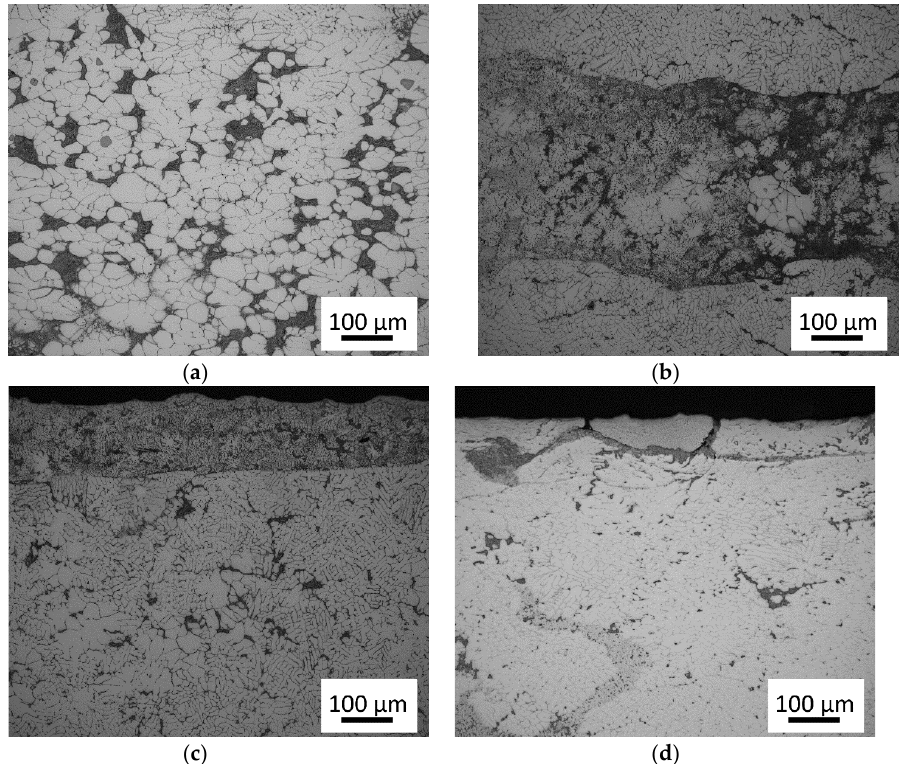
Figure 3. Microstructure of central bands in the Al-Li-Cu-Mg-Zr-Sc alloy in transverse ( a ) and longitudinal ( b ) sections. Supersaturated near-surface bands in the Al-Li-Cu-Mg-Zr-Sc strip ( c ) and surface bleeds in the Al-Li-Cu-Mg-Zr ( d ) alloy, longitudinal